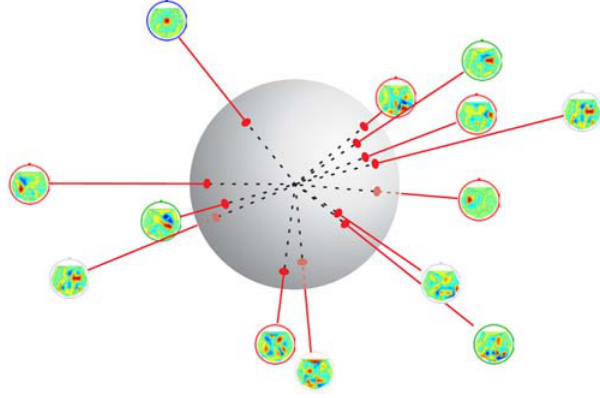
Figure 2. Projection of CSP filters onto the ( C 2 1)-dimensional hypersphere. Distances between filters are defined by the angles between the projected filters.